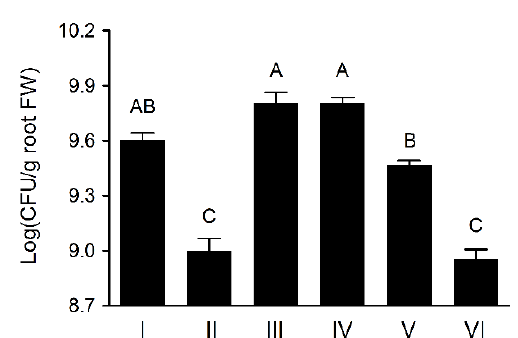
Figure 4. Colonization population in wheat rhizosphere by Pseudomonas sp. UW4 strains in axenic tissue culture bottles. Data marked with different uppercase letters were statistically different at p < 0.01 based on the least significant difference (LSD) multiple comparison test. Other notes: Same as Figure 1. The uppercase letters indicate the statistically different at p < 0.01.